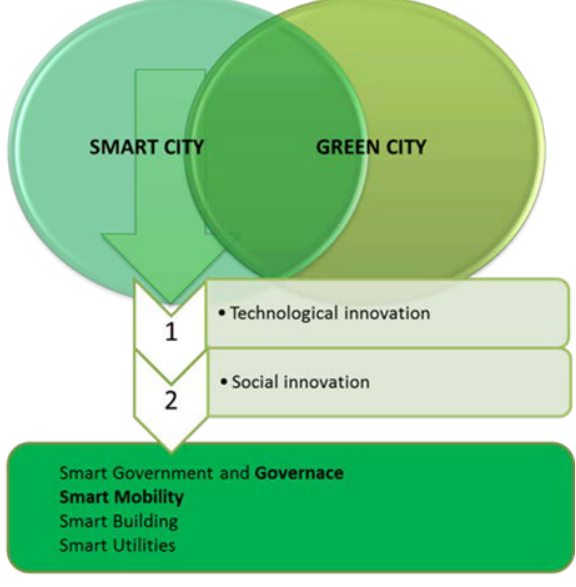
Figure 1: General framework of green smart city approach Source: own